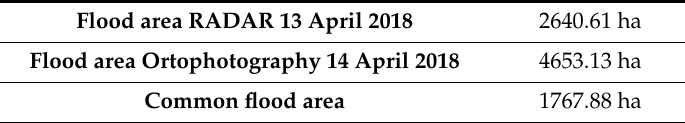
Table 5. Flooded surface values in the Ribera